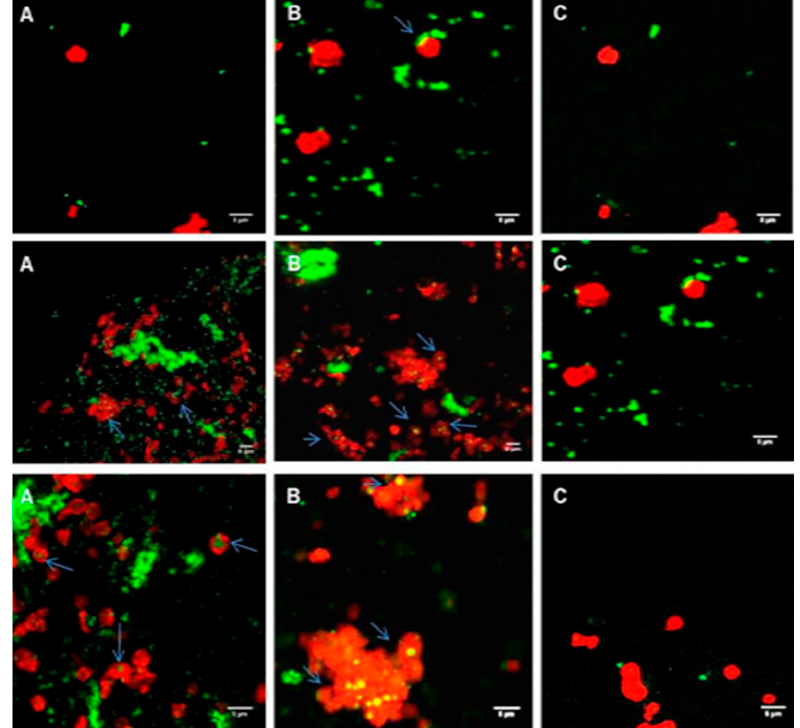
Figure 5. Confocal microscopy images of platelets in PRP (red) incubated with coumarin ‐ labelled PLGA ‐ PEG NPs (green) at 2.2 mg/mL. ( A ) For 1 min; ( B ) For 5 min; ( C ) For 30 min. Platelets in PRP were fluorescently labelled with phalloidin ‐ TRITC at 0.25 mg/mL and fixed using 1% formaldehyde Upper panel, 113 nm NPs; middle panel, 321 nm NPs; lower panel, 585 nm NPs. Magnification 100×, scale bar represents 5 μ m.